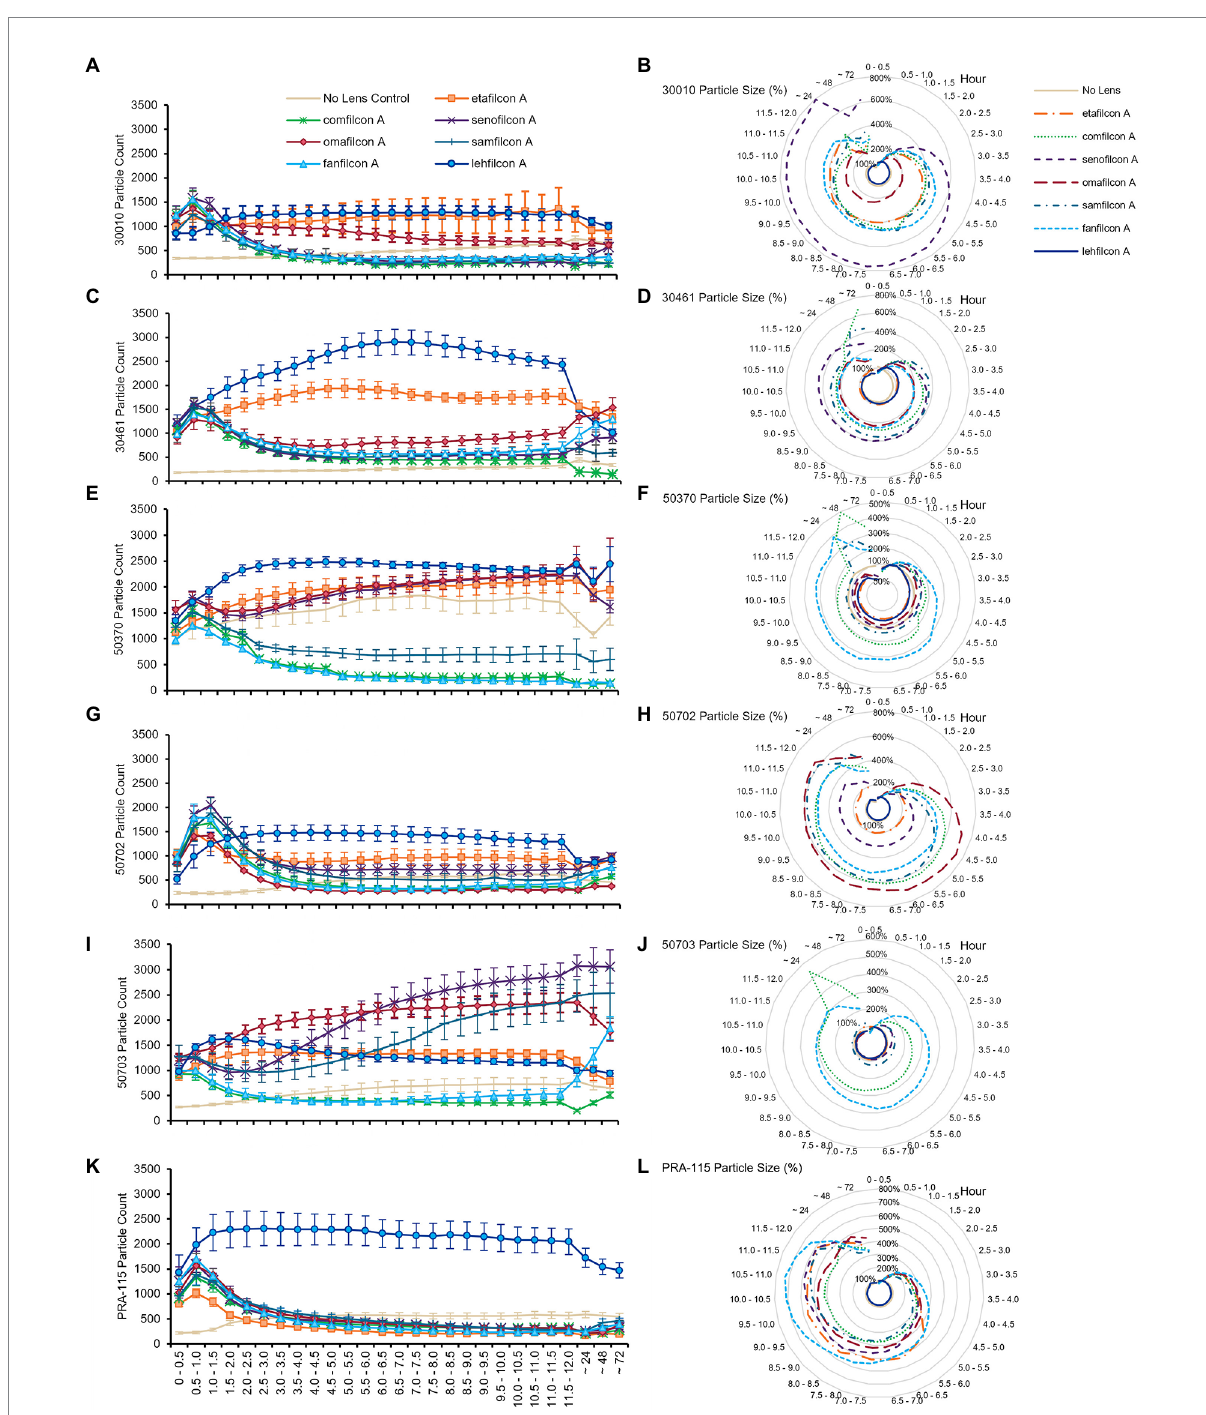
FIGURE 3 Acanthamoeba demonstrated significantly less aggregation on lehfilcon A lenses compared to other lens materials. Mean ± SE of (A) ATCC 30010 count, (B) ATCC 30010 particle size, (C) ATCC 30461 count, (D) ATCC 30461 particle size, (E) ATCC 50370 count, (F) ATCC 50370 particle size, (G) ATCC 50702 count, (H) ATCC 50702 particle size, (I) ATCC 50703 count, (J) ATCC 50703 particle size, (K) ATCC PRA-115 count, (L) ATCC PRA- 115 particle size. Size is normalized to the baselines obtained in the 0.5–1.0 h. Statistical comparisons noted in Supplementary Figures S3 and S4. Matching representative images presented in Figures 4 and 5. n = 6 per